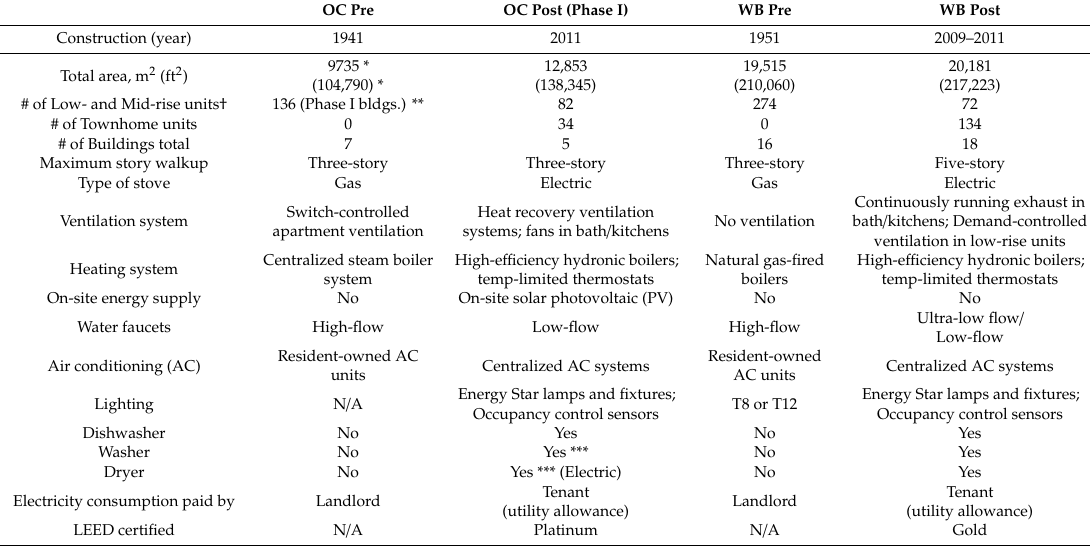
Pre- and post-redevelopment building characteristics at Old Colony (OC) and Washington-Beech